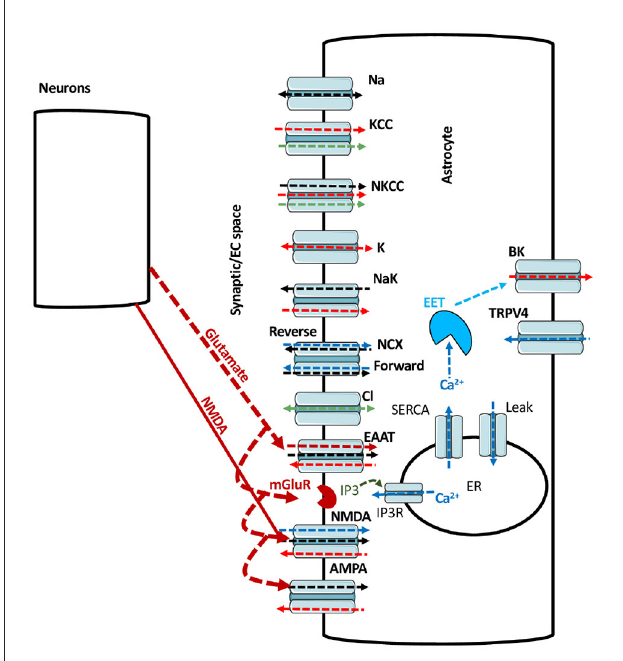
FIGURE1 A schematic of the main pathways incorporated in model. The black, red, blue, green, and maroon arrows represent Na + , K + , Ca 2+ , Cl - , and glutamate fluxes respectively. The arrow heads represents the direction of the flux.